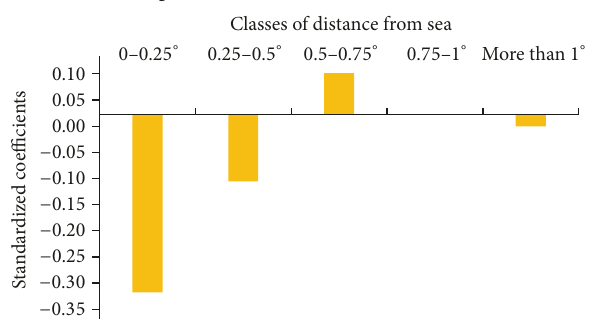
Figure 11: Average of standardized coefficients for different classes of the